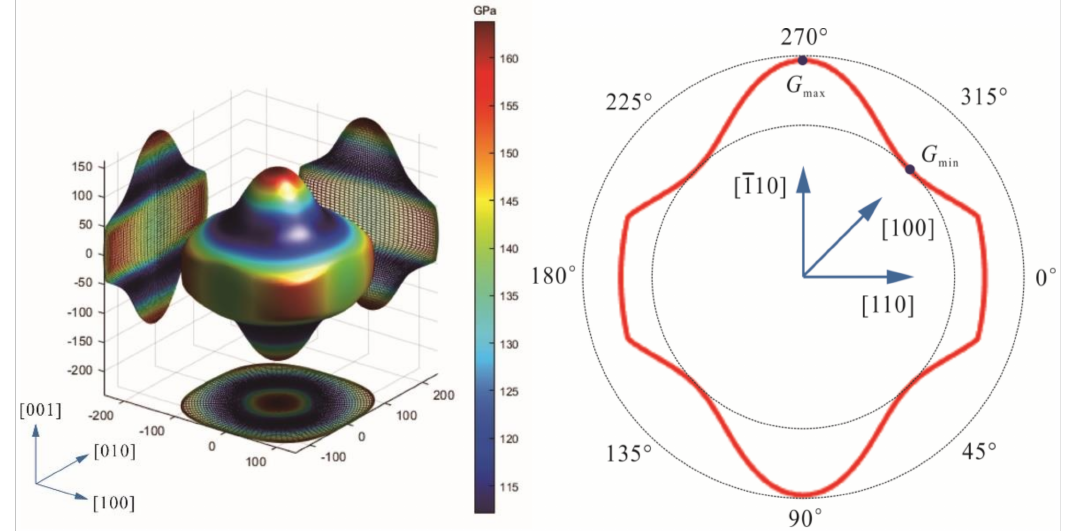
Figure 4. 3D diagram of shear modulus and elastic modulus of crystal plane (100) for Mo 5 SiB 2